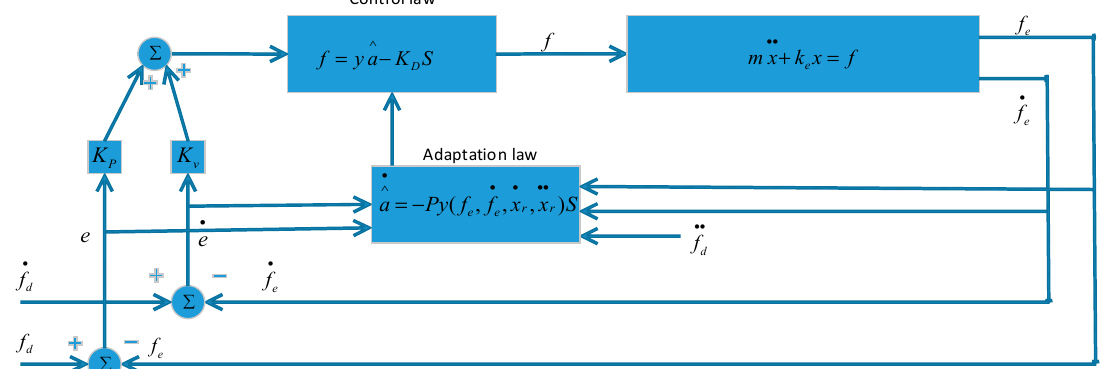
Figure 7. Adaptive control structure.